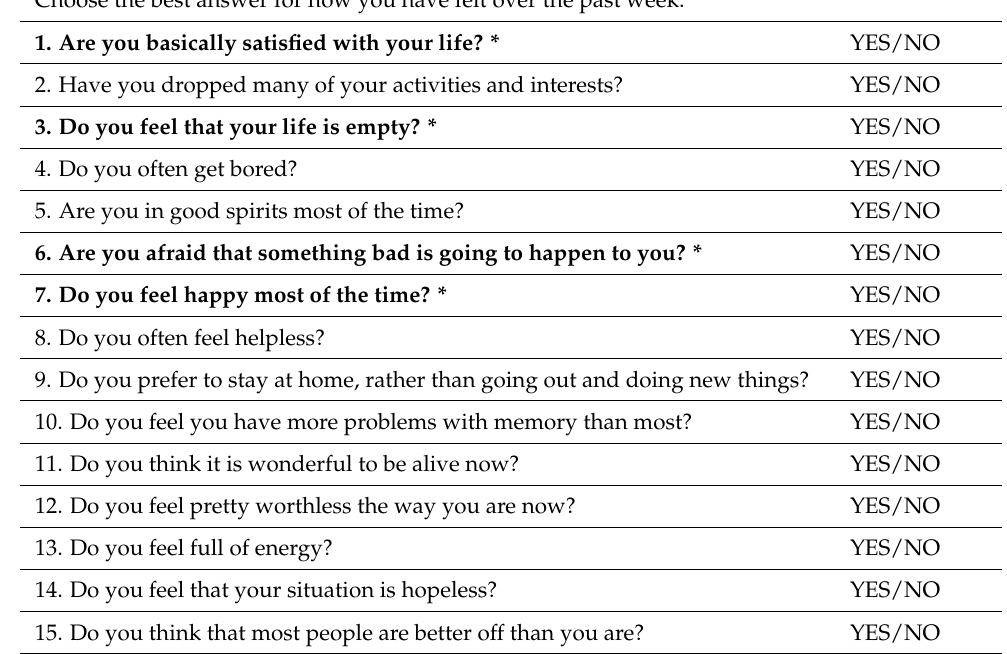
Table A2. The Geriatric Depression Scale—15 item